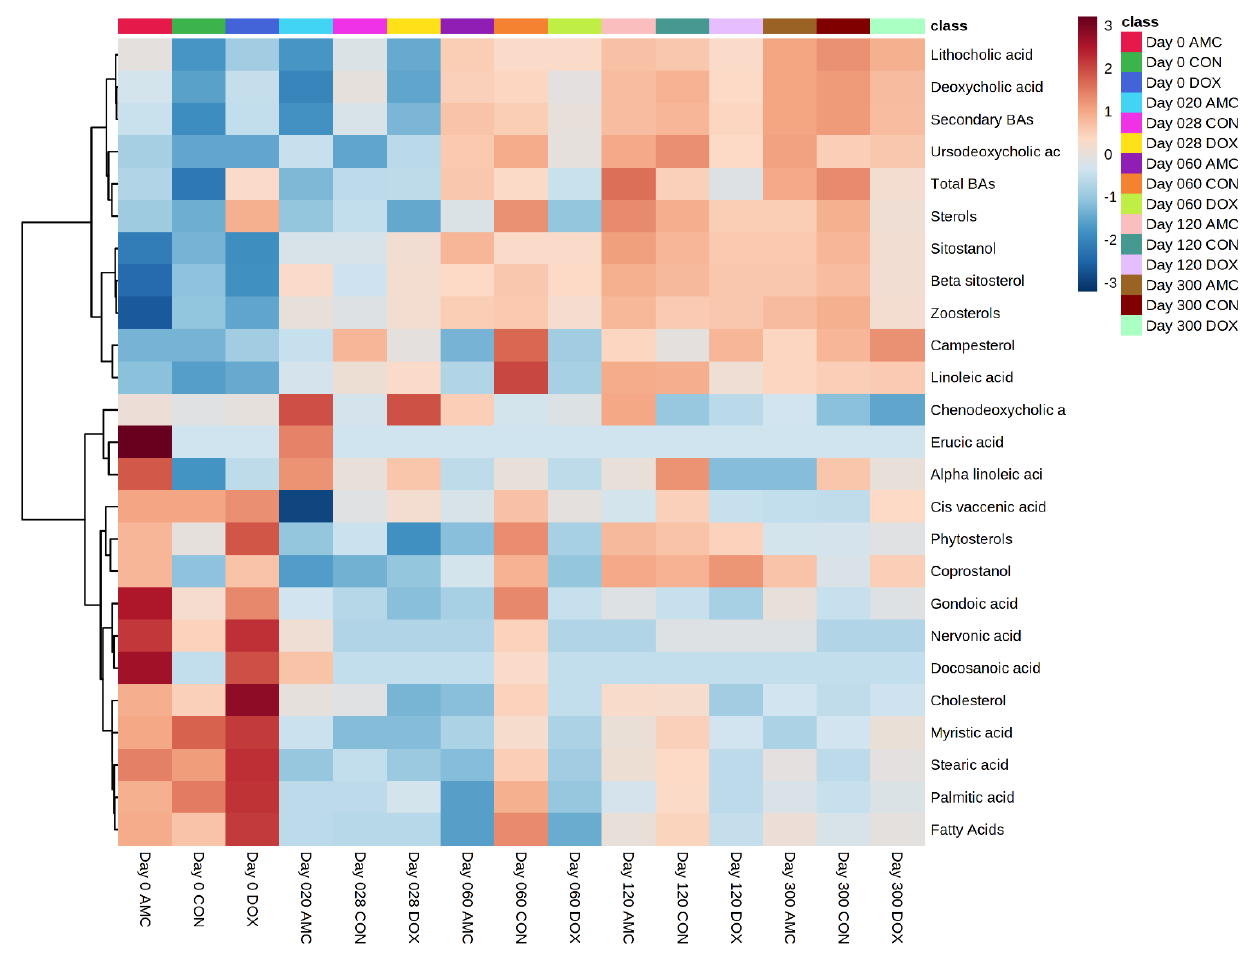
Figure 9. Heatmap clustering metabolites in feces of CON, AMC, and DOX cats over time (days 0, 20/28, 60, 120 300). For simplicity, the figure only displays the average concentrations of the top 25 metabolites that were different ( q < 0.05) based on a liner mixed-effects analysis. Each row represents the average intensity of one metabolite for all three groups (CON, AMC, and DOX) and for all sampling times.